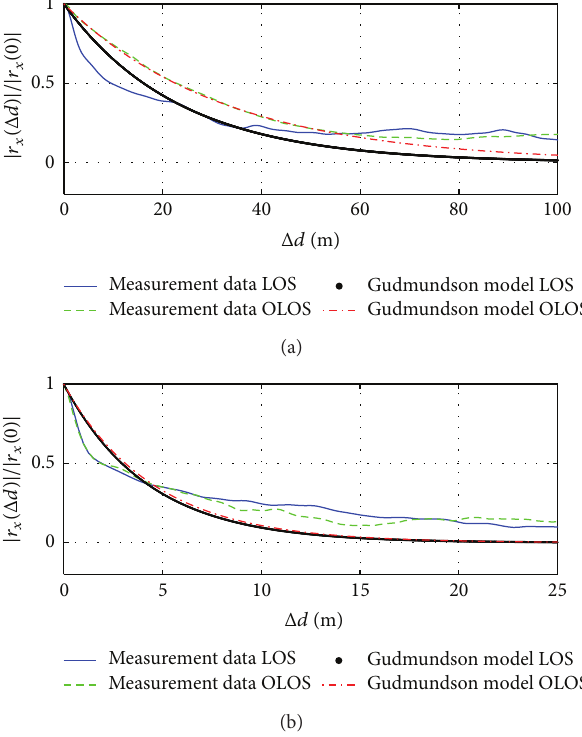
Figure 7: Measured autocorrelation function and model according to (8) for LOS and OLOS data: (a) highway scenario and (b) urban